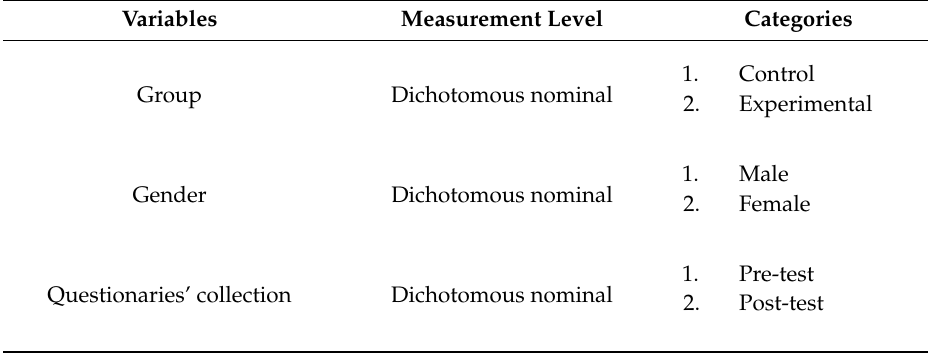
Table 1. Identification of research